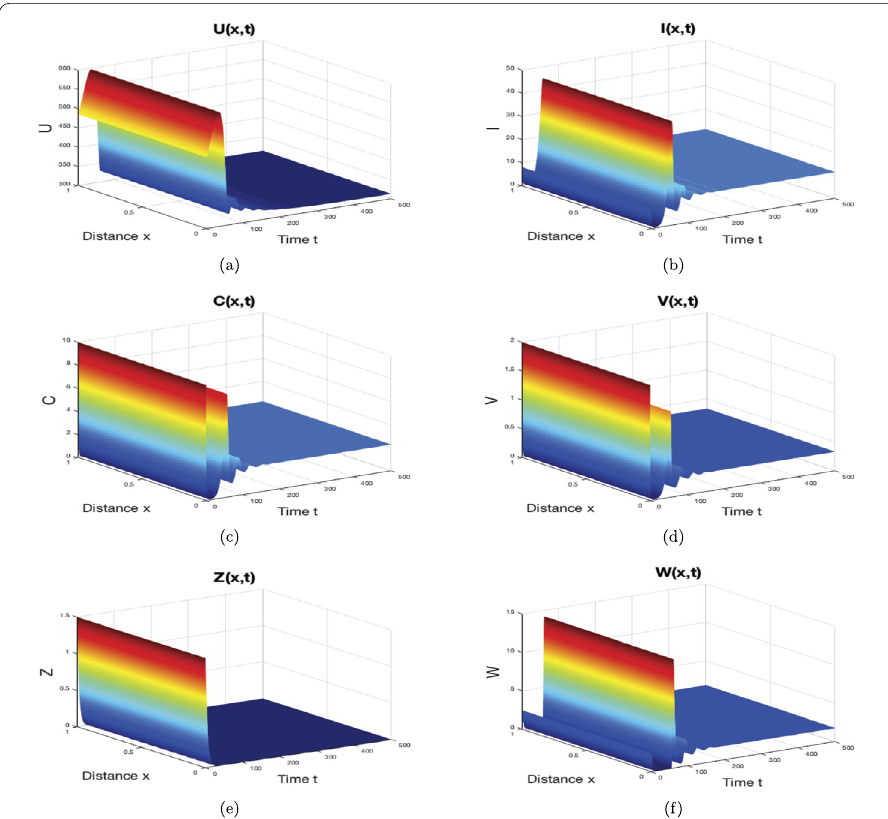
Figure 3 The numerical simulations of system (44)–(46) when R 1 > 1 and R 3 ≤ 1. The infection equilibrium M 2 is globally asymptotically stable. The sub-figures show the spatiotemporal behaviors of ( a ) uninfected hepatocytes, ( b ) infected hepatocytes, ( c ) capsids, ( d ) viruses, ( e ) CTLs, and ( f ) B